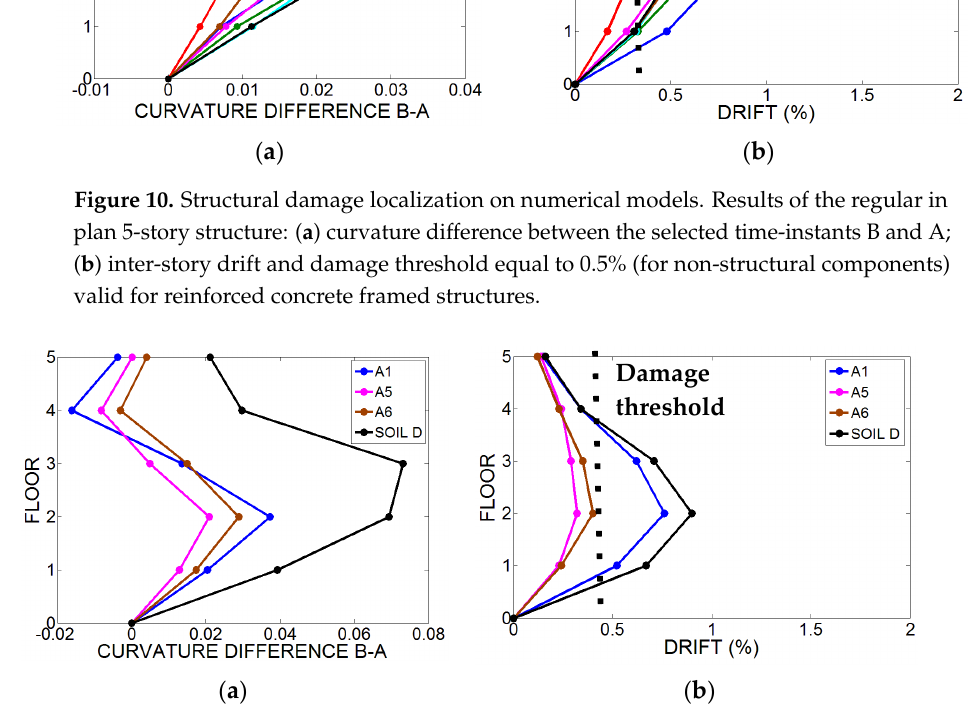
Figure 11. Structural damage localization on numerical models. Results of the 5-story regular in plan structure with infill panels: ( a ) curvature difference between the selected time-instants B and A; ( b ) inter-story drift and damage threshold equal to 0.5% (for non-structural components) valid for reinforced concrete framed structures.